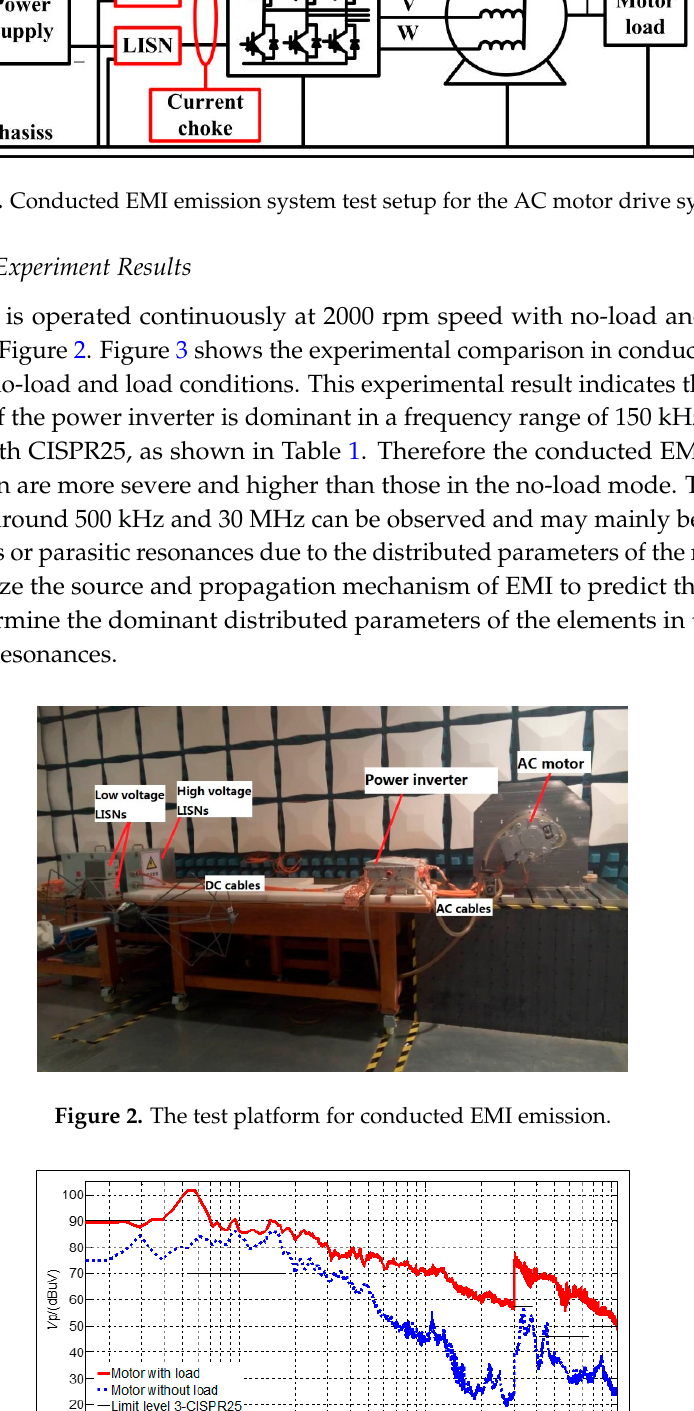
Figure 3. Comparison of measurement with load and measurement without load.